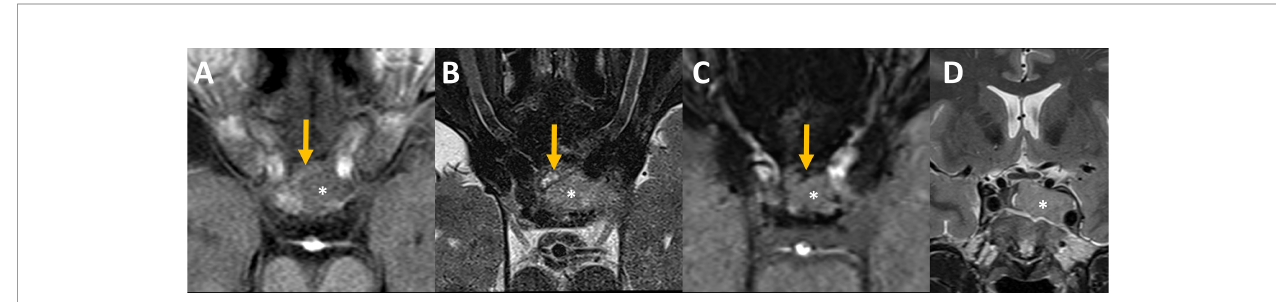
FIGURE 2 | Pre-operative MRI Axial MR imaging focused on the sella at admission (A – C) : The intra-sellar lesion (star) was heterogeneous on its anterior aspect. Some bloody components (orange arrows) that appeared slightly hyperintense on unenhanced T1 (A) , hyperintense with an hypointense rim on T2 spin echo (B) and hypointense on susceptibility weighted images, SWI, (C) were intercalated between the bone and the rest of the lesion. (D) Coronal MR imaging showed pituitary adenoma with invasion of the left cavernous sinus, grade 3b according to Knosp classi fi cation (17).